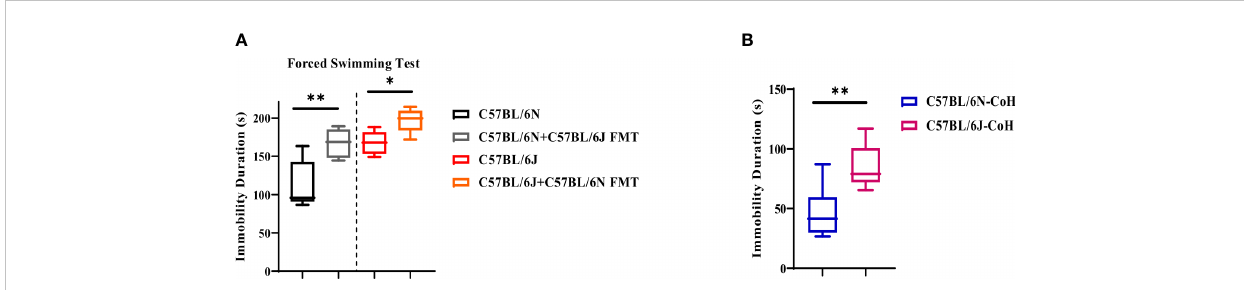
FIGURE 4 Microbial and environmental factors are dispensable for depression-like behavior pattern in C57BL/6 sub-strains. Immobility duration in C57BL/6N and C57BL6/J mice upon (A) FMT and (B) after long-term co-housing. Results are representative of three independent experiments with 5 – 7 mice/ group. Data are expressed as mean ± S.E.M. * P < 0.05, ** P < 0.001, by two-tailed unpaired Student